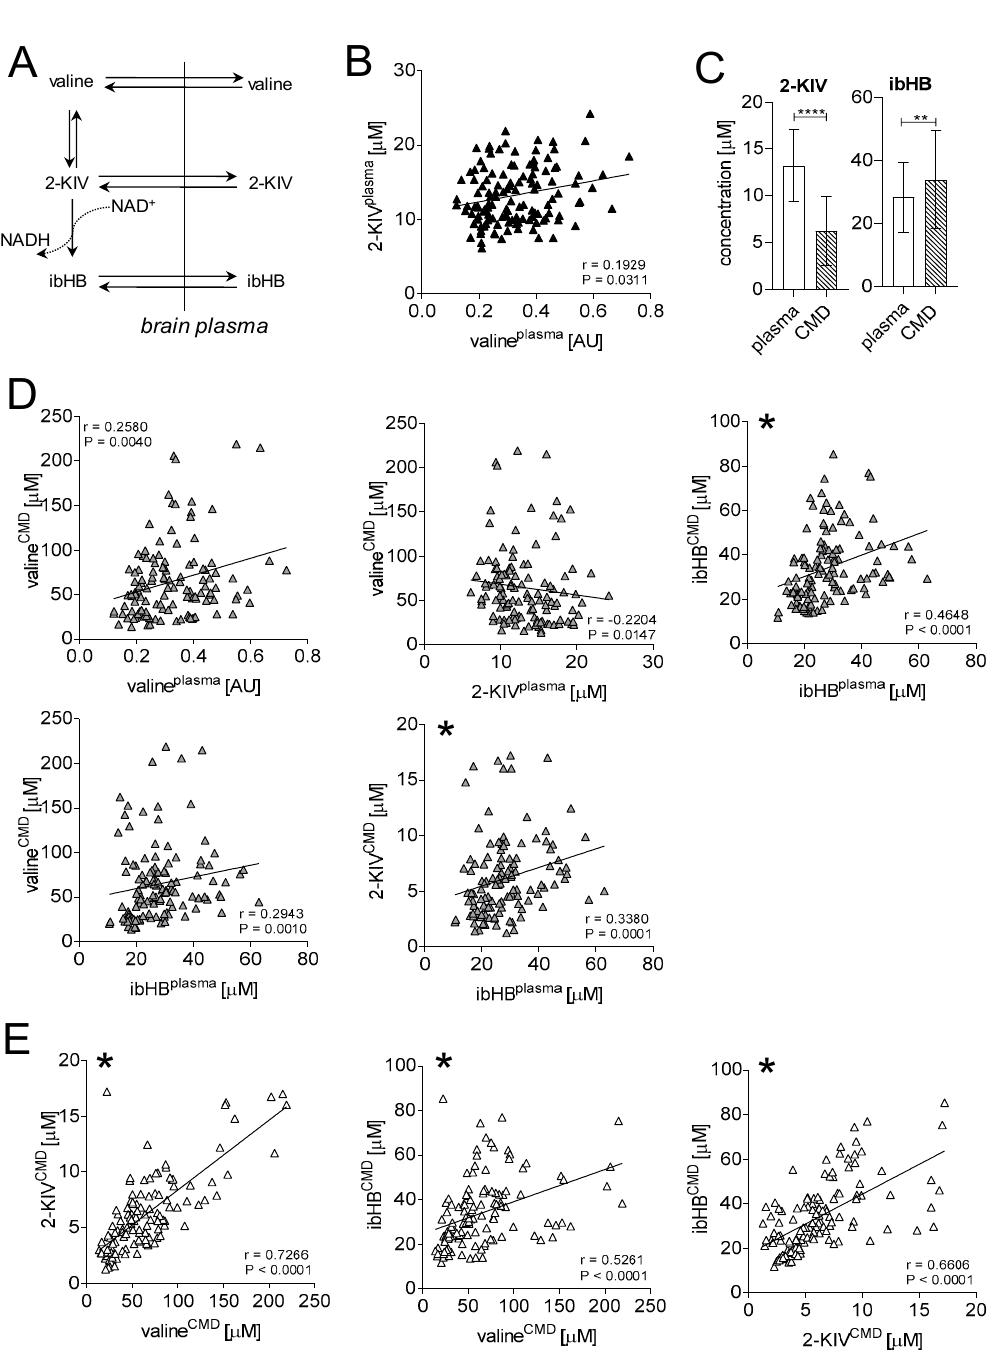
Figure 1. Correlation analysis of plasma and CMD metabolites identified previously as predictive markers of TBI outcome [2]. ( A ) Schematic overview of valine metabolism and transport of intermediates to the brain. ( B ) Plasma-specific Spearman correlation—plasma valine and 2-KIV. ( C ) Average concentrations of 2-KIV and ibHB measured in plasma and CMD. ( D ) Spearman correlations between plasma valine CMD valine, plasma 2-KIV and CMD valine, plasma ibHB and CMD ibHB, plasma ibHB and CMD valine, and plasma ibHB and CMD 2-KIV. ( E ) Brain-specific Spearman correlations—CMD valine and 2-KIV, CMD valine and ibHB, and CMD 2-KIV and ibHB. ** p < 0.01, and **** p < 0.0001. Mann–Whitney test. Graphs with * on the left corner are correlations that survived Bonferroni correction ( α = 0.05 / 15 = 0.0033). AU: arbitrary unit. The line represents linear regression.